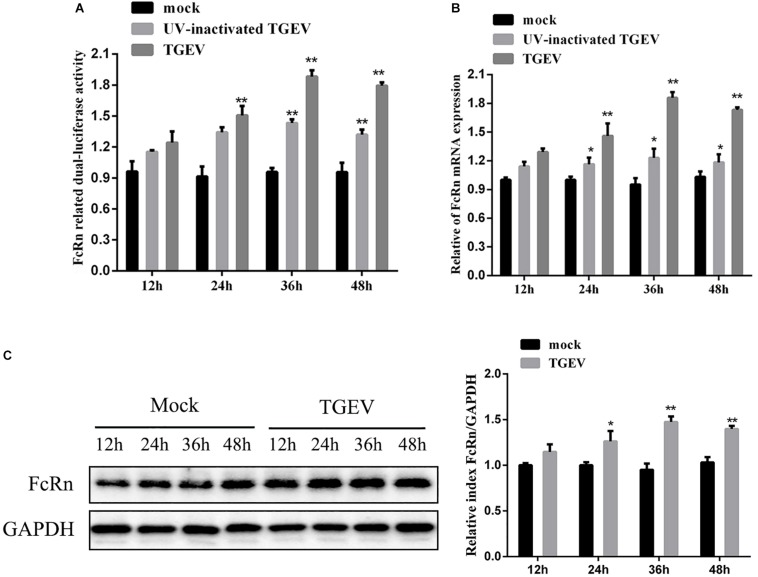
TGEV-induced activation of FcRn depends on viral replication. (A) IPEC-J2 were co-transfected with pRL-TK and FcRn-Luc, followed by alive TGEV or UV-inactivated TGEV (MOI 1). Cells were harvested at 12, 24, 36 or 48 hpi, and the lysates were analyzed by dual-luciferase assay. (B) IPEC-J2 cells were infected with alive TGEV or UV-inactivated TGEV at a MOI of 1. Cells were harvested at 12, 24, 36 or 48 hpi, and the lysates were analyzed by RT-qPCR. (C) IPEC-J2 were infected with alive TGEV at a MOI of 1. Cells were harvested at 12, 24, 36 or 48 hpi, and the lysates were analyzed by Western blot. ∗p < 0.05, ∗∗p < 0.01.